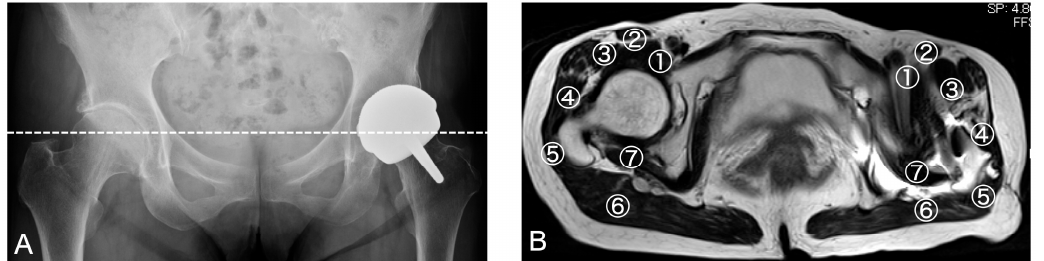
Figure 3. Representative hip resurfacing case assessed using X-ray and MRI. Apparent complications in this representative patient were not found by hip X-ray ( A ). The periprosthetic muscles consisted of 1. iliopsoas, 2. sartorius, 3. rectus femoris, 4. gluteus minimus, 5. gluteus midius, 6. gluteus maximus, and 7. short rotators which were observed by axial MRI ( B ) from the ASIS to lessor trochanteric level on T1 and T2 STIR images. If the contours of the targeting muscles cannot be observed, the muscle is regarded as unassessable.